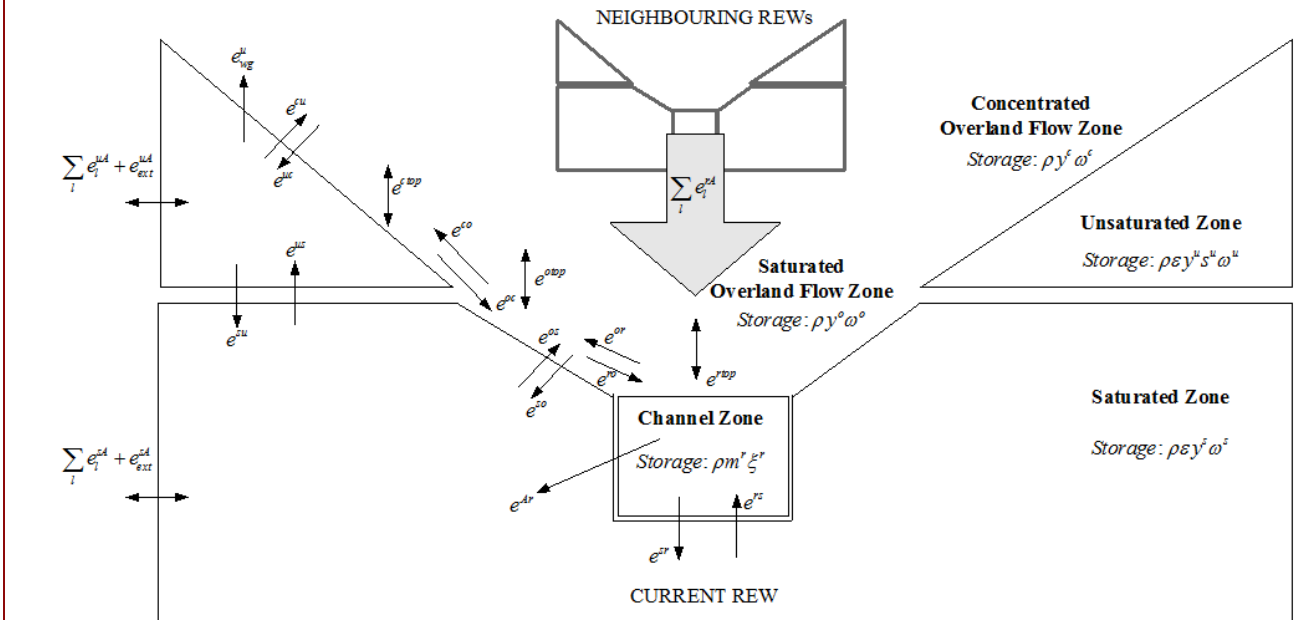
Figure 1. Schematized profile of a REW water balance and associated mass balance